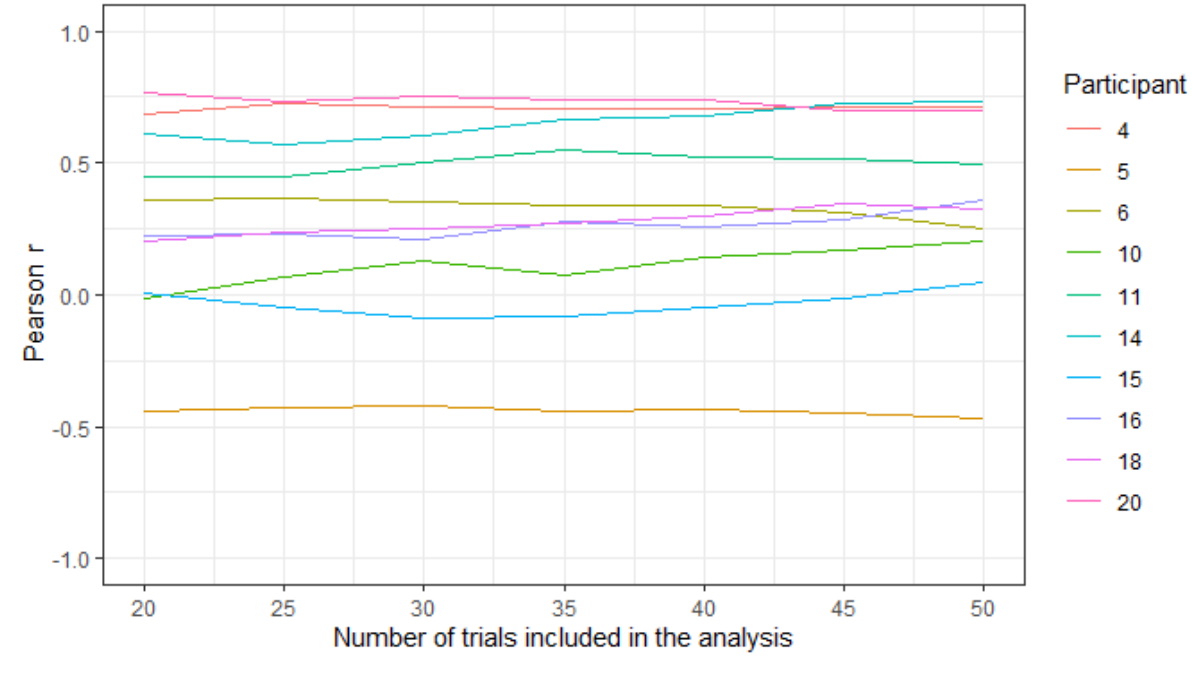
Figure 4. The correlation (Pearson r ) between psychomotor vigilance task reaction times and Karolinska Sleepiness Scale scores across all time points within participants. Only participants with more than 50% compliance (ie, completed at least 14 of the 28 possible assessments) are included